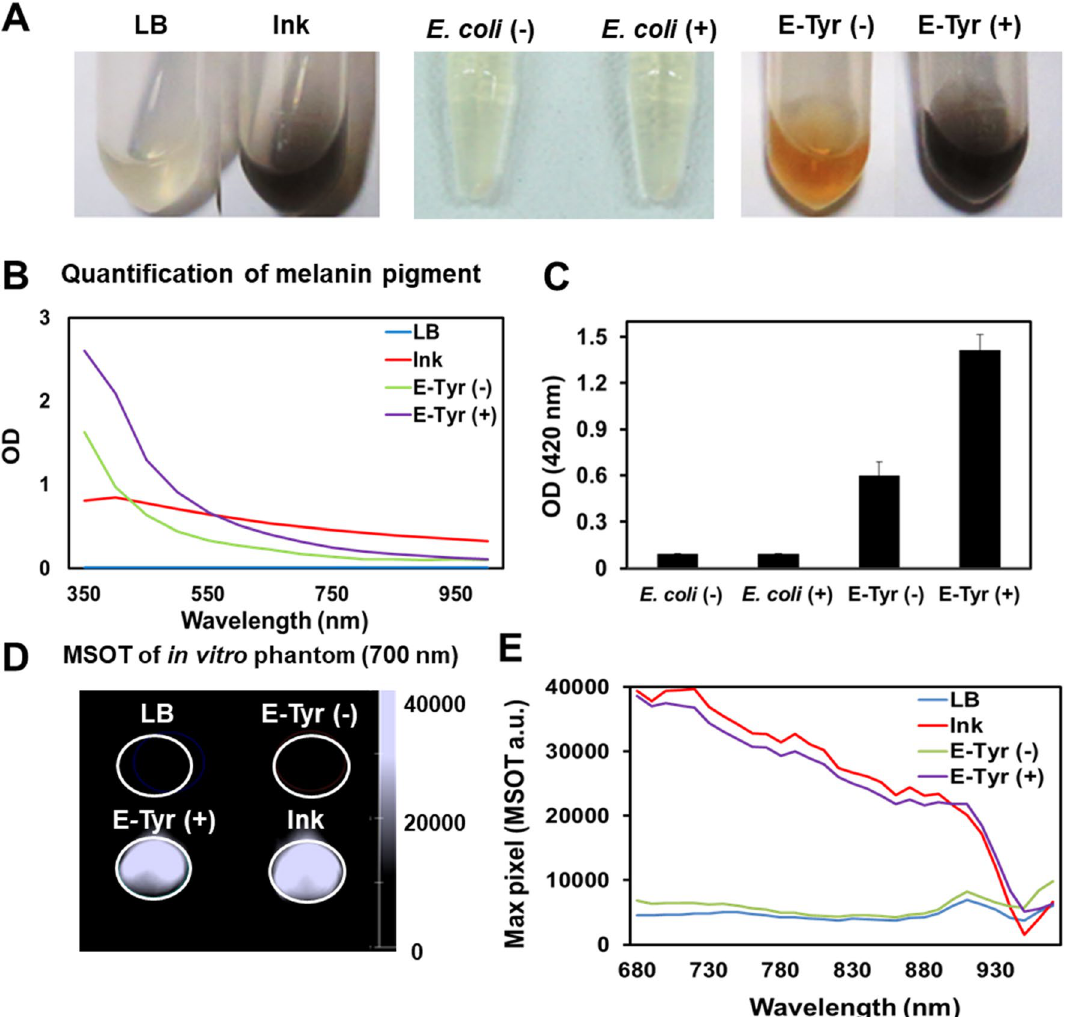
medium) and ink control, (middle) supernatant of E. coli with the tyrosinase-expression vector (control bacteria) cultured with ( E. coli (+)) or without ( E. coli (−)) L-tyrosine supplementation, and (right) supernatant of E. coli carrying the tyrosinase-expression vector cultured with (E-Tyr(+)) or without (E-Tyr(−)) l-tyrosine supplementation. ( B ) Optical density measurements of LB, ink, E-Tyr (−) and E-Tyr (+) over the spectrum from 350 to 1000 nm. ( C ) Quantification of melanin pigment shown in ( A ), E. coli (−), E. coli (+), E-Tyr (−) and E-Tyr (+), using a spectrophotometer at 420 nm wavelength. ( D ) Optoacoustic in vitro phantom imaging of ( C